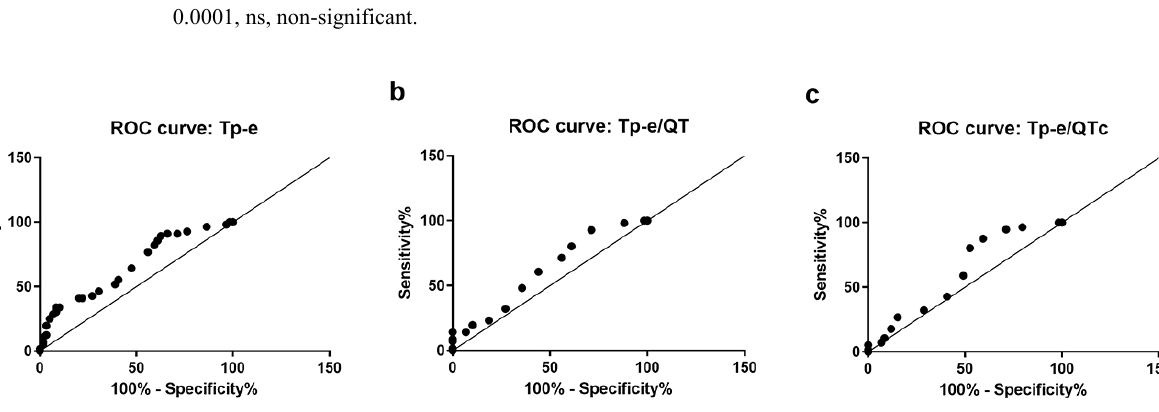
Fig. 3. The relationship between clinical sensitivity (100%) and specificity (100%) for every possible cutoff is shown by receiver operator characteristic (ROC) curves for the ECG parameters (a) Tp-e, (b) Tp-e/QT, and (c)